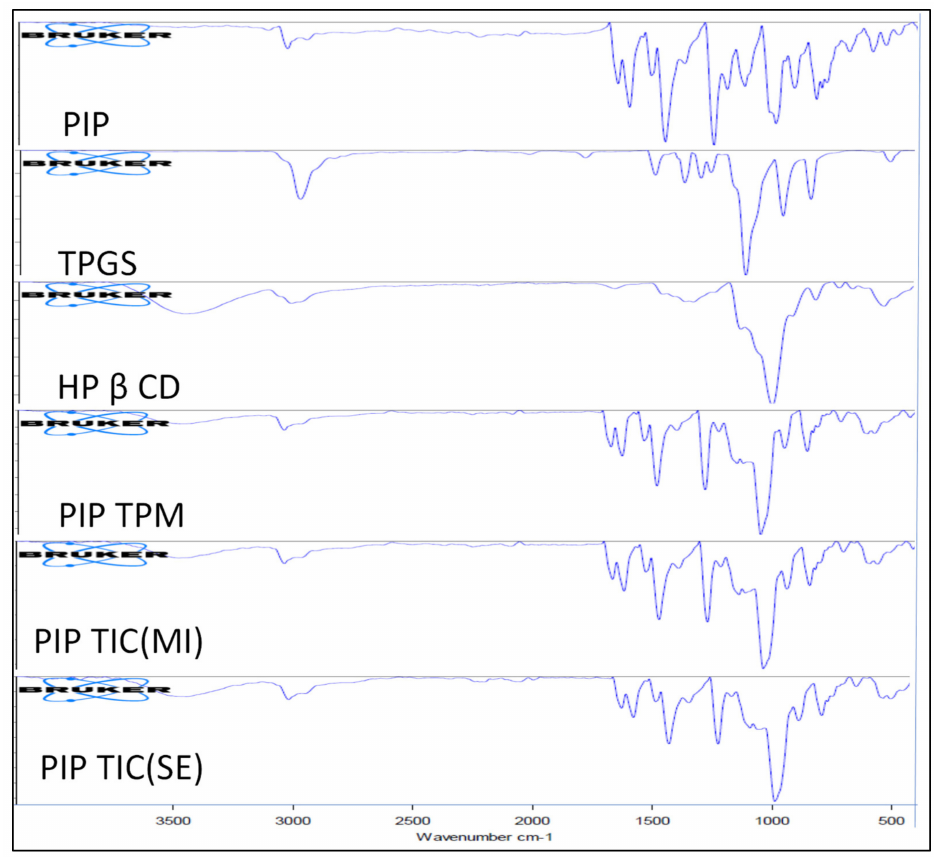
Figure 7. IR spectra of pure piperine, HP β CD, TPGS, PIP ternary physical mixture, piperine ternary inclusion complex (MI), and piperine ternary inclusion complex